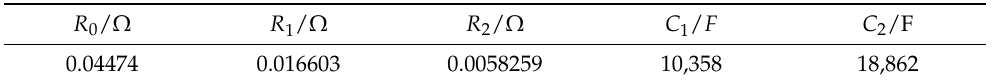
Table 2. Battery model parameter